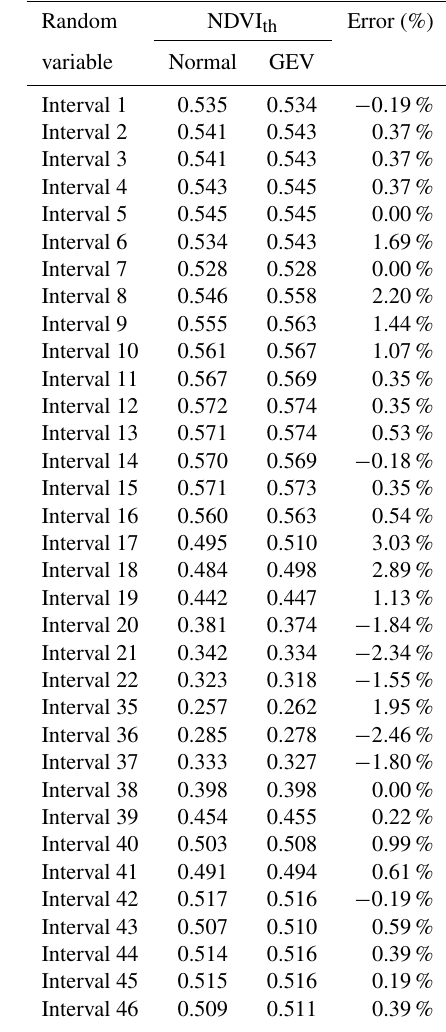
Table 5. First column: time intervals of approximately 8d through- out the year. Second column: NDVI thresholds (NDVI th ) based